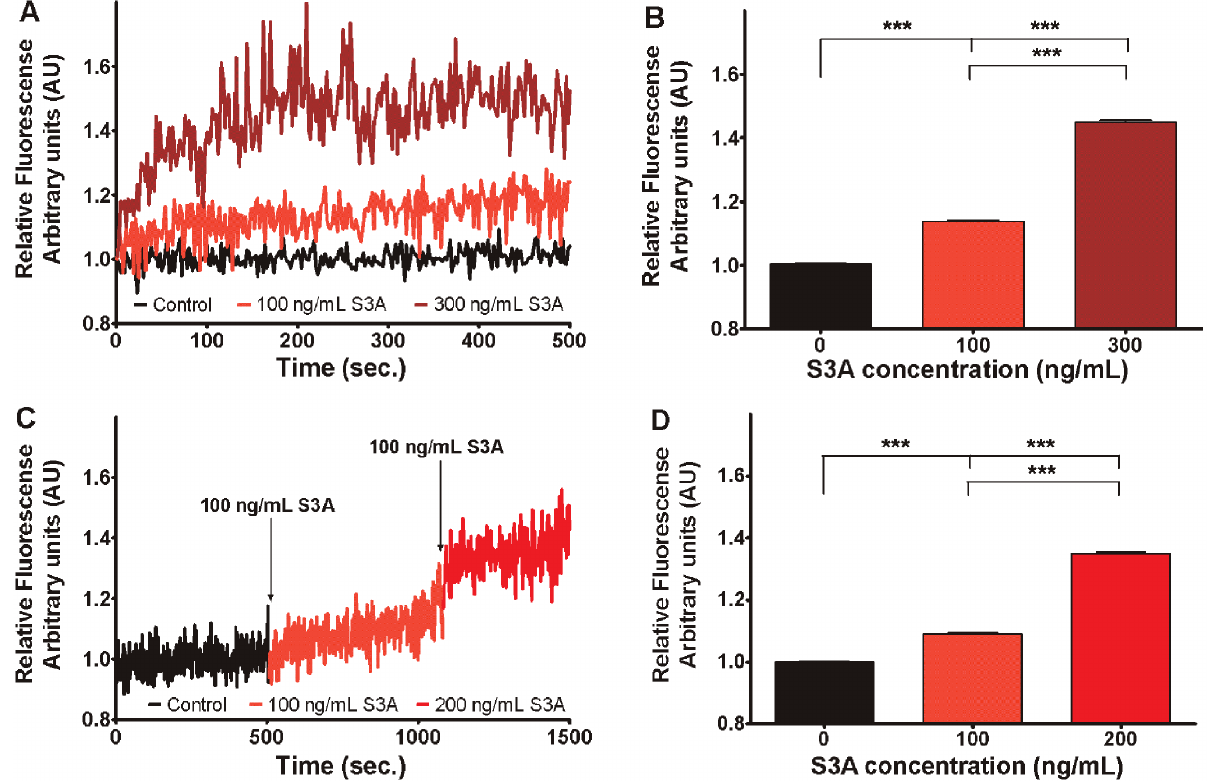
Figure 2. Increase of Sema3A induced Fura-2 fluorescence 340/380 ratio, corresponding to increased [Ca 2 + ] i concentration in growth cones. Two different protocols are shown. In panel A, different dishes were used to evaluate the Sema3A concentration dependent effect, while in panel C, the effect of addition of supplemental 100 ng/mL Sema3A concentration was measured recording the same ROIs. All data have been normalized to the fluorescent ratio at the time point preceding Sema3A addition (the value of 340/380 ratio at this point equals to 1 arbitrary unit AU). A) black curve indicates the relative fluorescence before the addition of Sema3A at indicated concentrations (light red curve and dark red curve). B) Bars represent the mean 6 SEM of 340/380 ratio in presence of different Sema3A concentrations. C) Curve indicates relative fluorescence in control condition before addition of 100 ng/mL Sema3A following by addition of 100 ng/mL Sema3A (final concentration 200 ng/mL) at indicated time points. D) Bars represent the mean 6 SEM of 340/380 ratio in presence of different Sema3A concentrations. To reveal statistical significance Dunn’s post hoc test for Kruskal-Wallis analysis was performed. In the panels B and D upper and lower lines represent statistical difference of the corresponding groups from control and from 100 ng/mL Sema3A respectively. Here *** denotes p ,